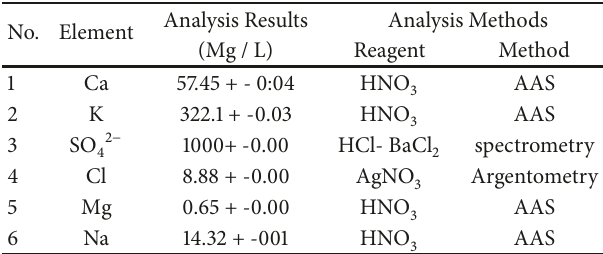
Table 1: Chemical Element in sea water from Jember, East Java, In- donesia.